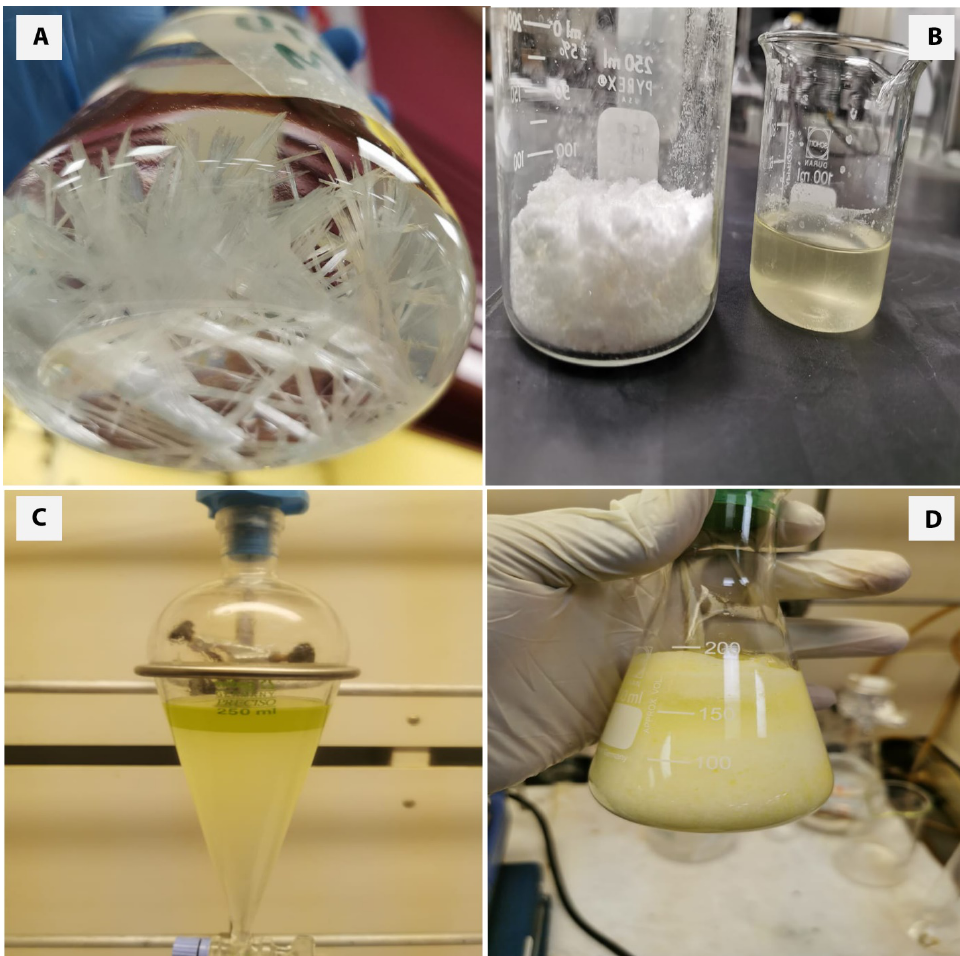
Figure 3. ( A ) Urea solution crystallization when temperature decreases. ( B ) Urea–methanol mixture after vacuum filtration. ( C ) washing with HCL-water solution and separation into upper layer of fatty acids and lower layer of urea concentrate. ( D ) Homogeneous mixture of urea, methanol, and fatty acids after